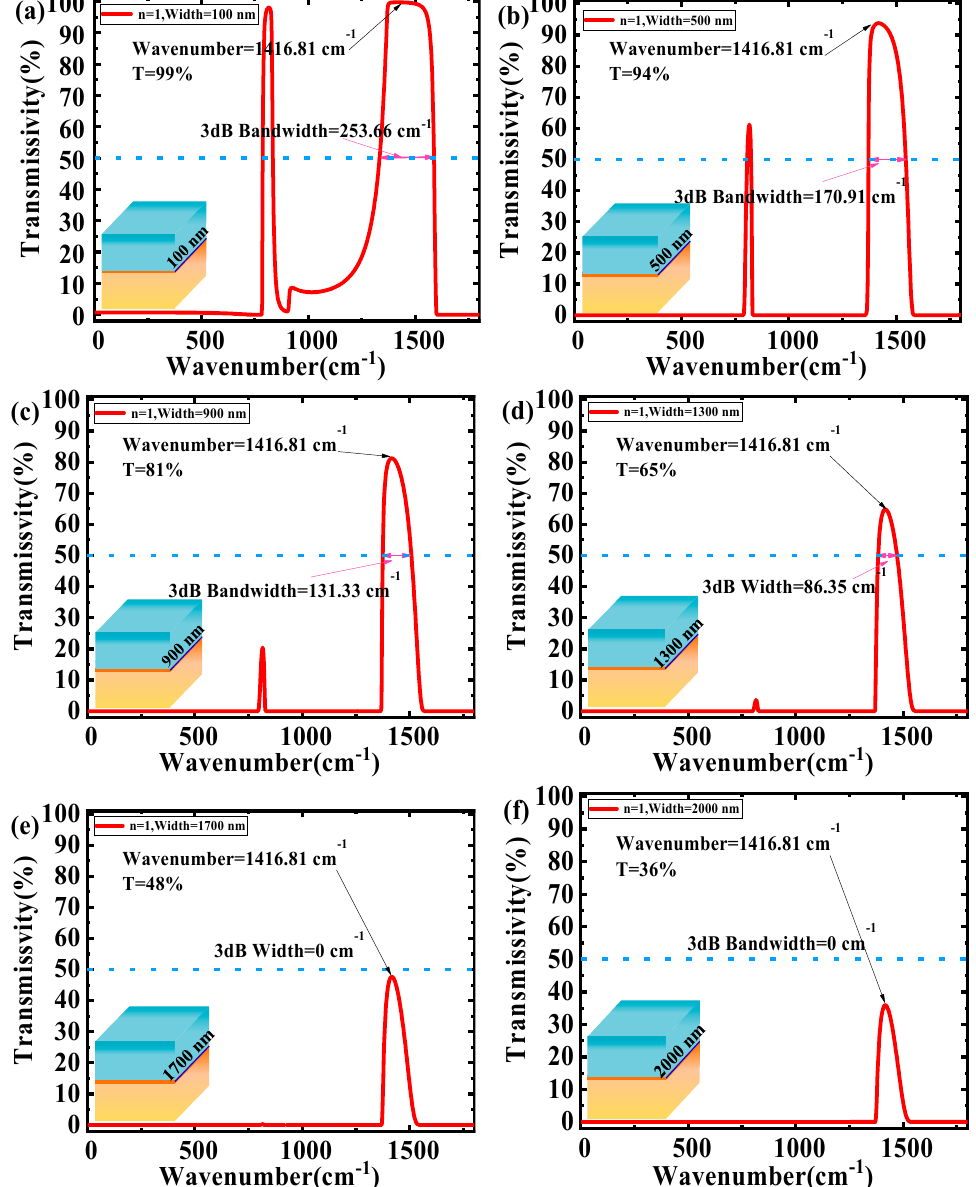
Figure 9. Transmissivity as a function of wavenumber in different structure width: ( a ) ε 1 = 1, ε 2 = 3.9, d = 100 nm and width =100 nm; ( b ) ε 1 = 1, ε 2 = 3.9, d = 100nm and width = 500 nm; ( c ) ε 1 = 1, ε 2 = 3.9, d = 100 nm and width = 900 nm; ( d ) ε 1 = 1, ε 2 = 3.9, d = 100nm and width = 1300 nm; ( e ) ε 1 = 1, ε 2 = 3.9, d = 100 nm and width = 1700 nm; and ( f ) ε 1 = 1, ε 2 = 3.9, d = 100 nm and width = 2000 nm.